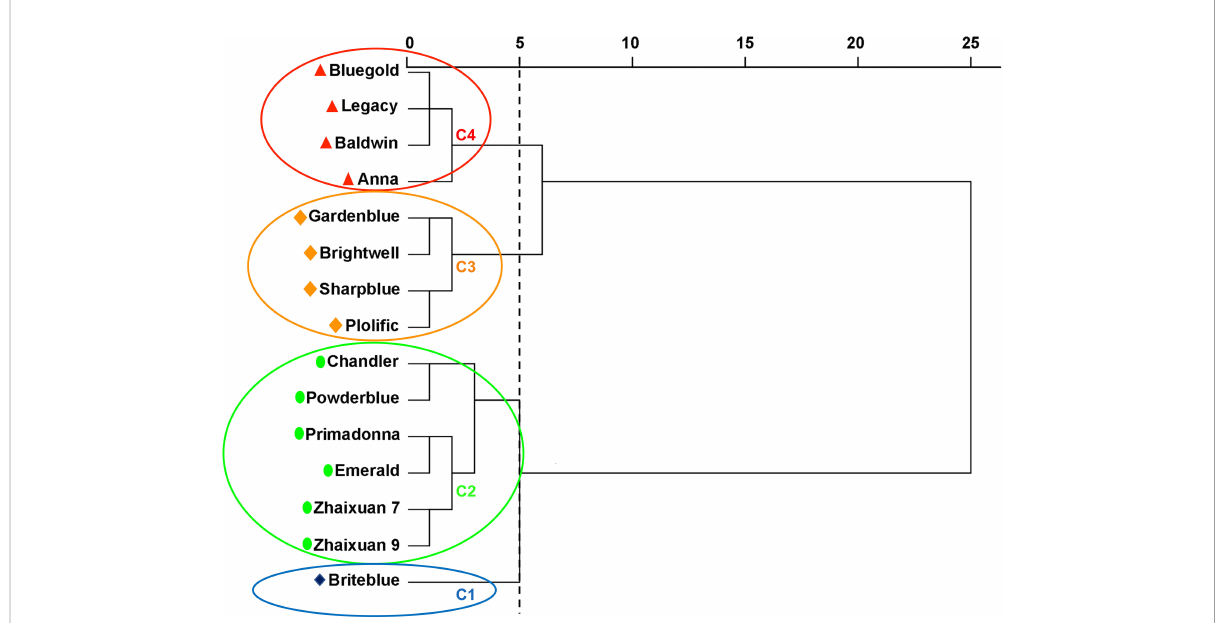
FIGURE 6 Euclidean distance cluster analysis to evaluate the resistance of 15 blueberry seedling cultivars to high soil pH stress. Blue circle C1 includes one high soil pH-tolerant blueberry cultivar, green circle C2 includes six intermediate high soil pH-tolerant blueberry cultivars, yellow circle C3 includes four low high soil pH-tolerant blueberry cultivars, and red circle C4 includes four high soil pH-sensitive blueberry